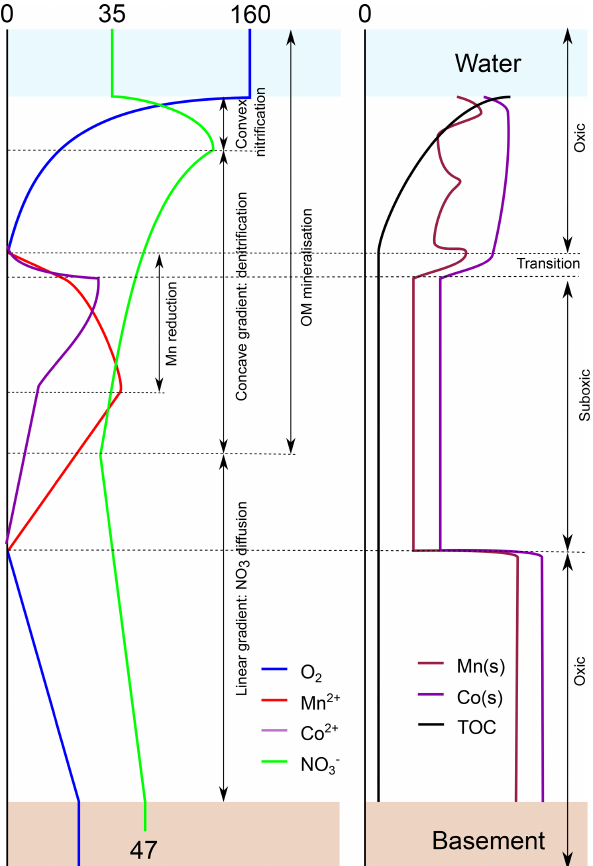
Figure 8. Conceptual model summarising the diagenetic processes discussed in this paper as a result of oxygen entering the sediment from the ocean bottom waters and from the oceanic basement. Left panel: porewater profiles. Right panel: solid fraction. Numbers refer to concentrations in micromoles per litre . The model is based on the profiles of inorganic species and TOC in